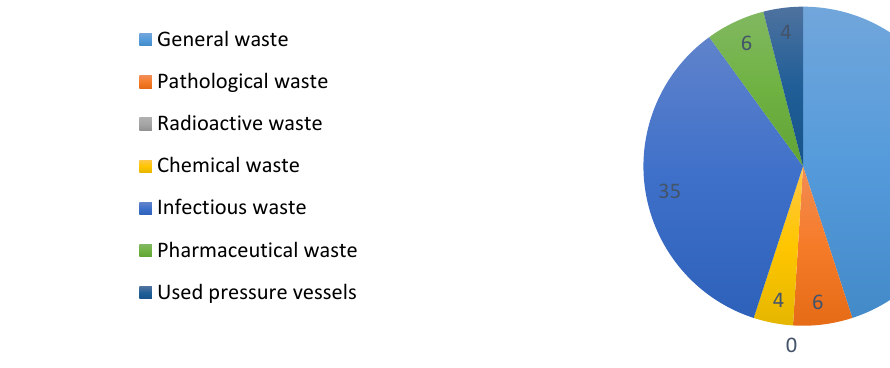
Figure 5. Percentage of waste in health centers, clinics, and offices from the perspective of